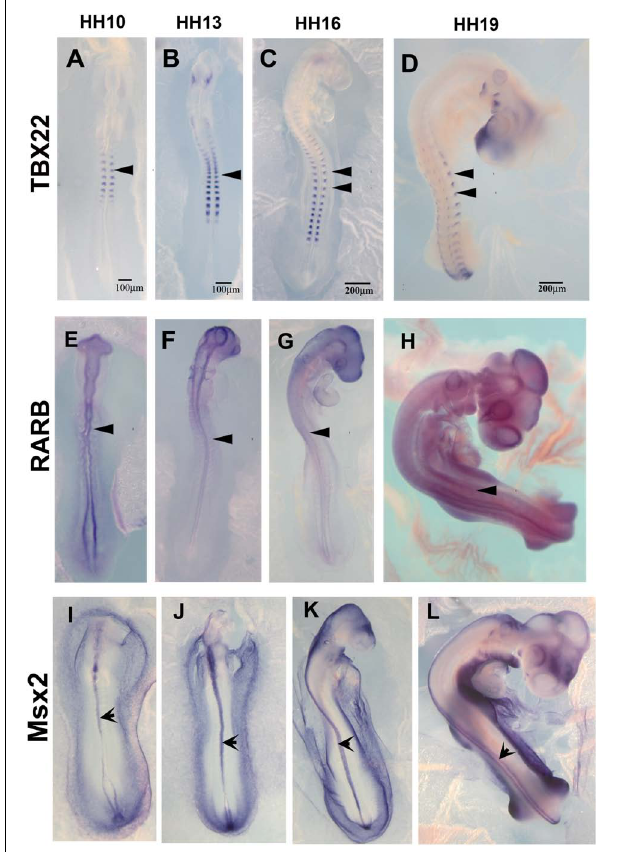
FIGURE 5 | Expression of downregulated genes. Chicken wholemount in situ for set of 3 upregulated genes at HH10, HH13, HH16, and HH19 chicken embryos. (A–D) Tbx22, arrowheads point to migrating tNCC or coalescing DRGs. (E–H) RARB, arrowheads point to NT and faint expression in tNCC or coalescing DRGs. (I–L) MSX2, arrowheads point to NT. Scale Bars are for